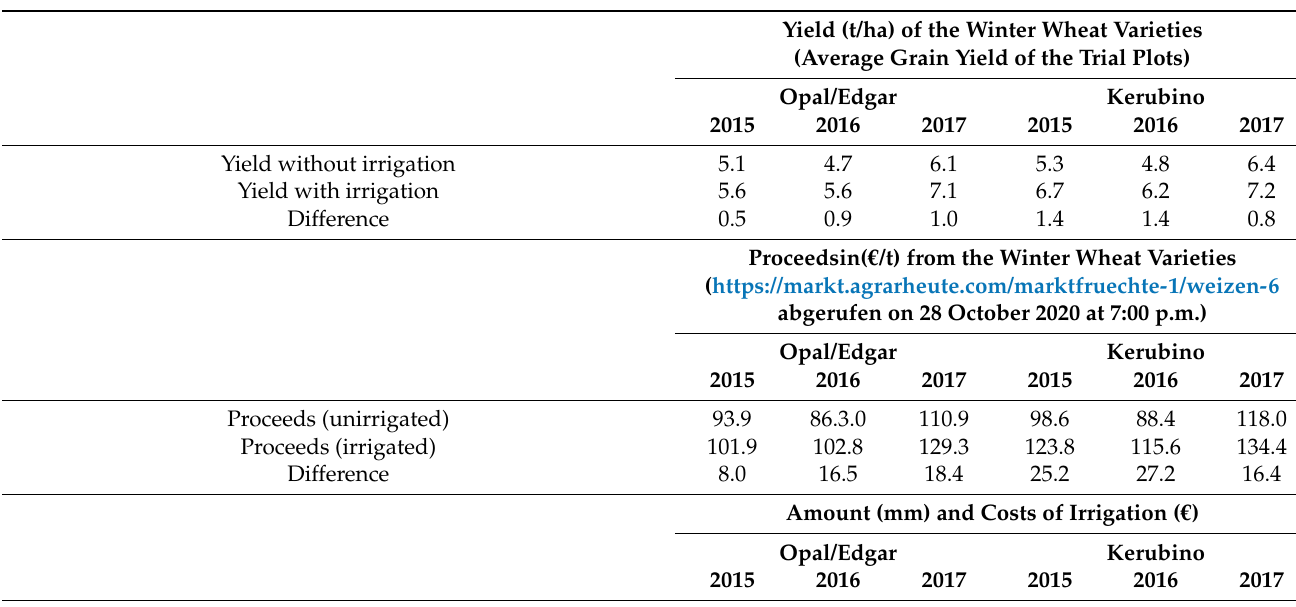
Table 7. Cost-effectiveness of the irrigation of winter wheat varieties Opal/Edgar and Kerubino from 2015 to 2017 in Marquardt.